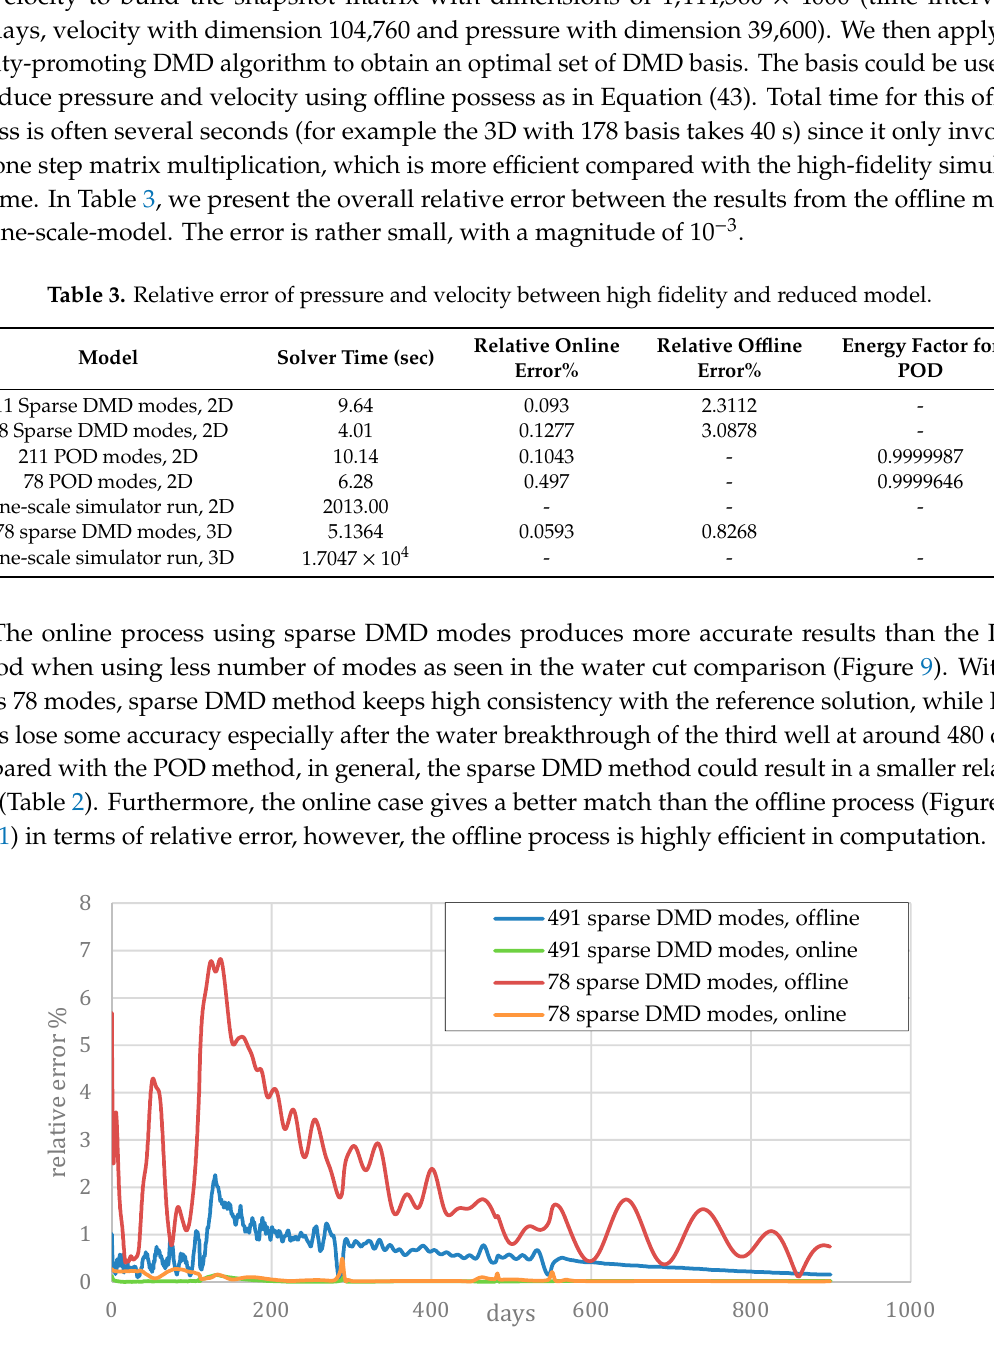
Figure 11. Relative error of pressure and velocity as the change of time in 3D reservoir. Table 3. Relative error of pressure and velocity between high fidelity and reduced model . Model